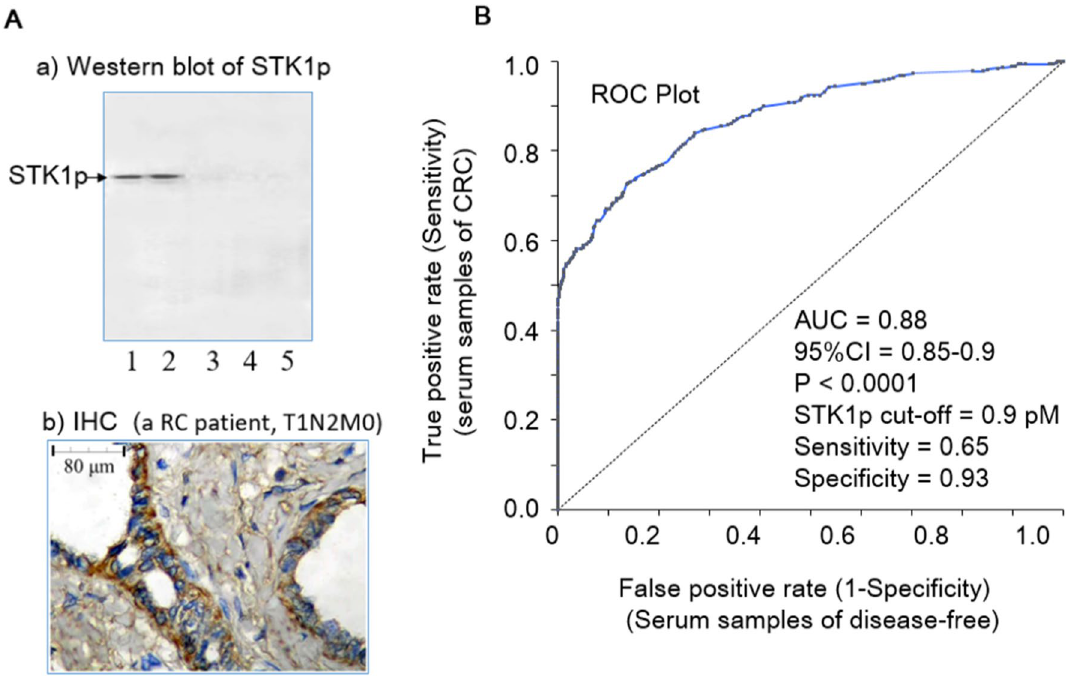
Fig. 1 Characteristics of TK1-IgY-pAb. A . Example of a patient with RC (T1N2M0). a Western blot of STK1p. The serum samples, presurgery (Lines 1 and 2, duplicate), and 6 months after surgery (Line 3); Serum sample from a disease-free person (Lines 4 and 5, duplicate). b ) TK1 immunohistochemistry (IHC) staining of RC tissue postsurgery (T1N2M0). Brownish-yellow TK1 was mainly in the cytoplasm. Blue staining was used to counterstain nuclei with hematoxylin. Magnification 200 × . B . Receiver operation characteristic (ROC) analysis. The analysis was based on STK1p values of 488 CRC patients and 488 tumor-free